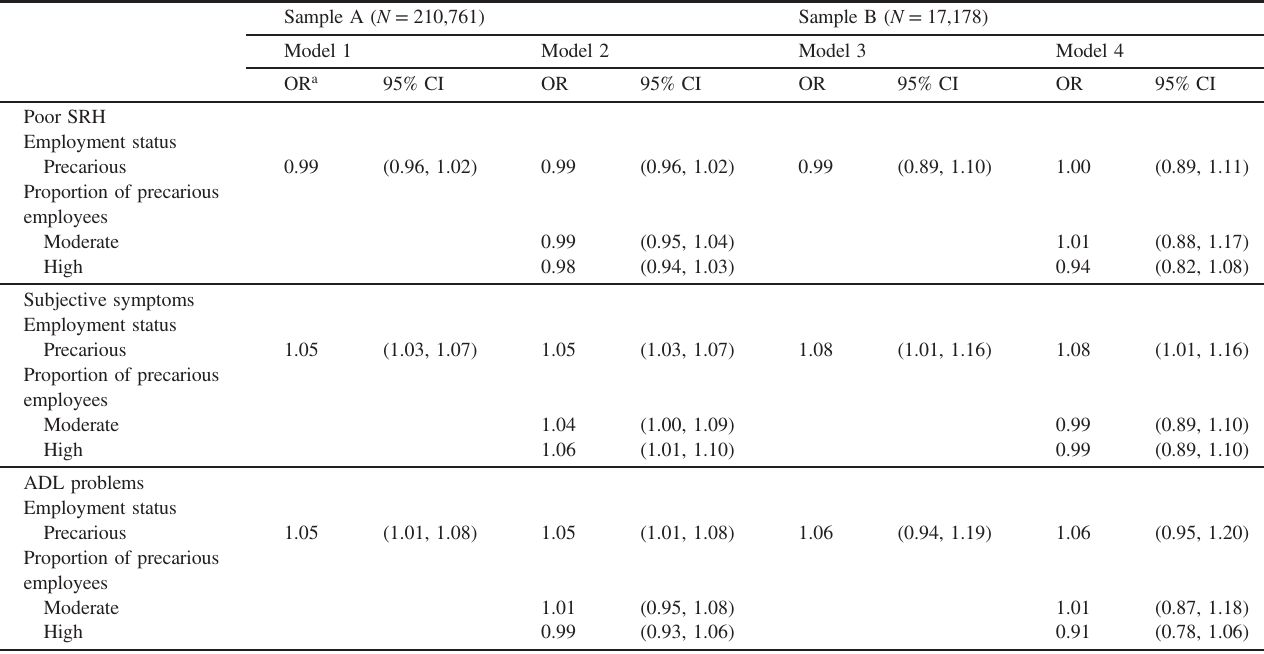
Table 6. Estimation results of multi-level logistic models to explain health outcomes for